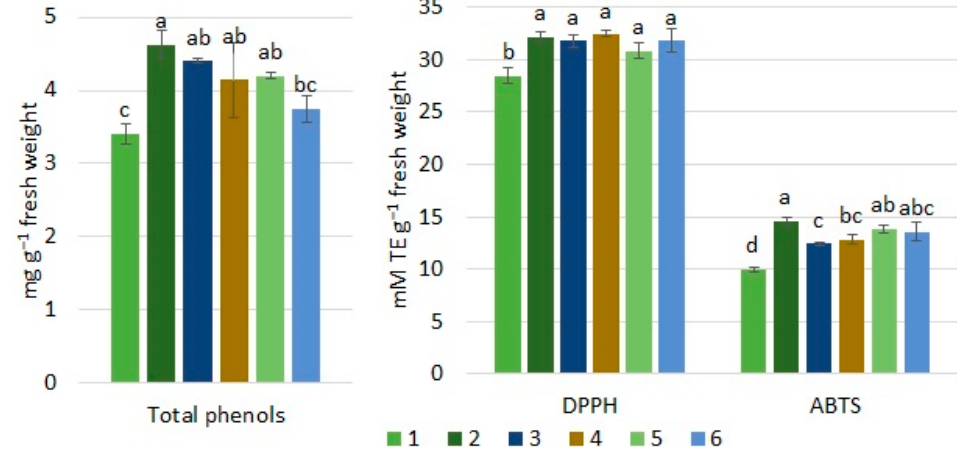
Figure 2. Influence of agrotechnological tools on total phenols, the 2,2–diphenyl–1–picrylhydrazyl (DPPH) and ABTS (2.2 (cid:48) -azino-bis (3-ethylbenzothiazoline-6-sulfonic acid) diammonium salt) radical scavenging activity in cv. Rubin apples on harvest time (commercial ripening) in average of three years. 1. Each year hand pruning forming slender spindle (control); 2. Mechanical pruning (each year); 3. Trunk incision using chain saw + mechanical pruning (each year); 4. Mechanical pruning (each year) + spraying with calcium-prohexadione; 5. Mechanical pruning + hand pruning + summer pruning; 6. Mechanical pruning one side, changing sides annually. Averages followed by different letter within the same compound indicate significant differences according to the Duncan’s least significant difference test ( p < 0.05). Error bars show standard